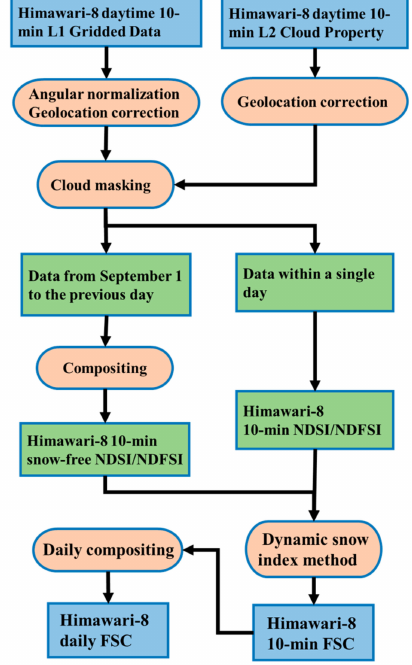
Figure 6. Flowchart of Himawari–8 AHI fractional snow cover